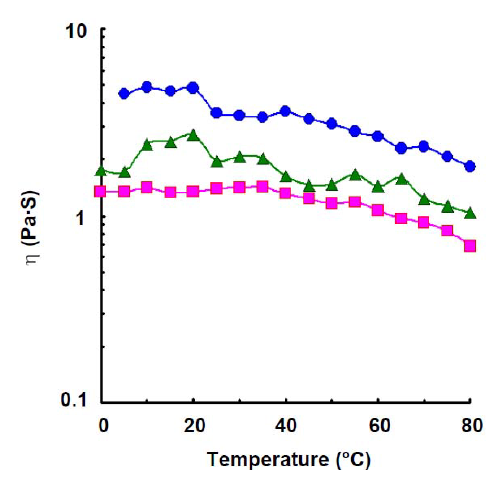
Figure 2. Effect of temperature on the viscosity of wheat amylose at various concentrations at 9.5 s − 1 . Concentration: 1.2%, ■; 1.4%, ▲; 1.6%,